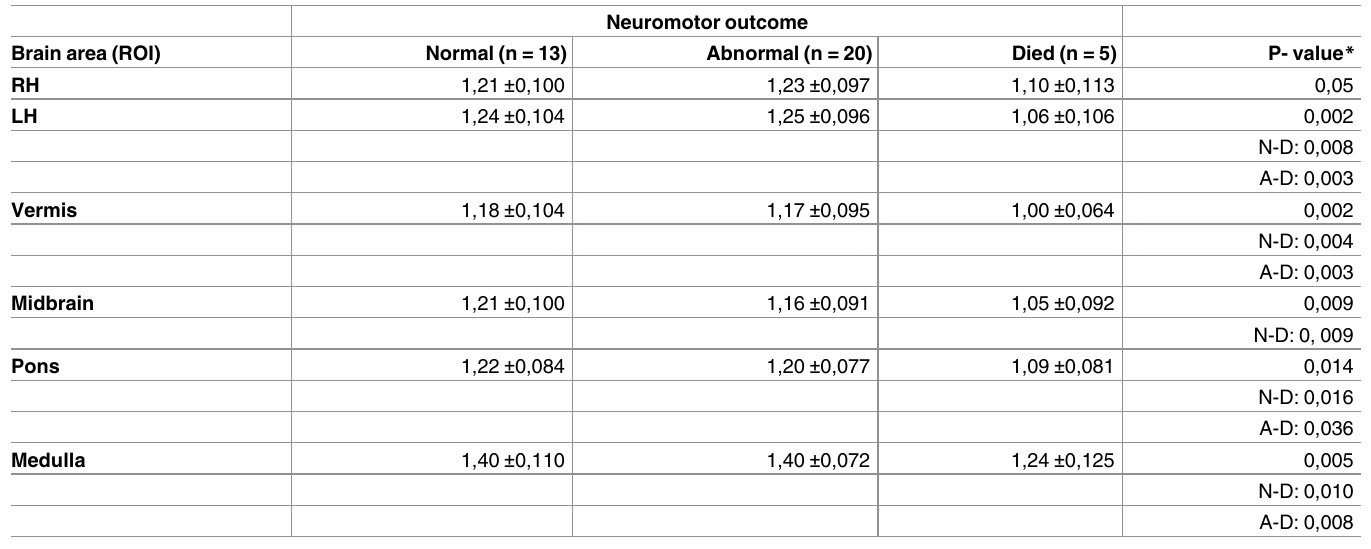
Table 4. The ADC mean (SD) x10 -3 /mm 2 /second at first MRI in six ROIs and neuromotor